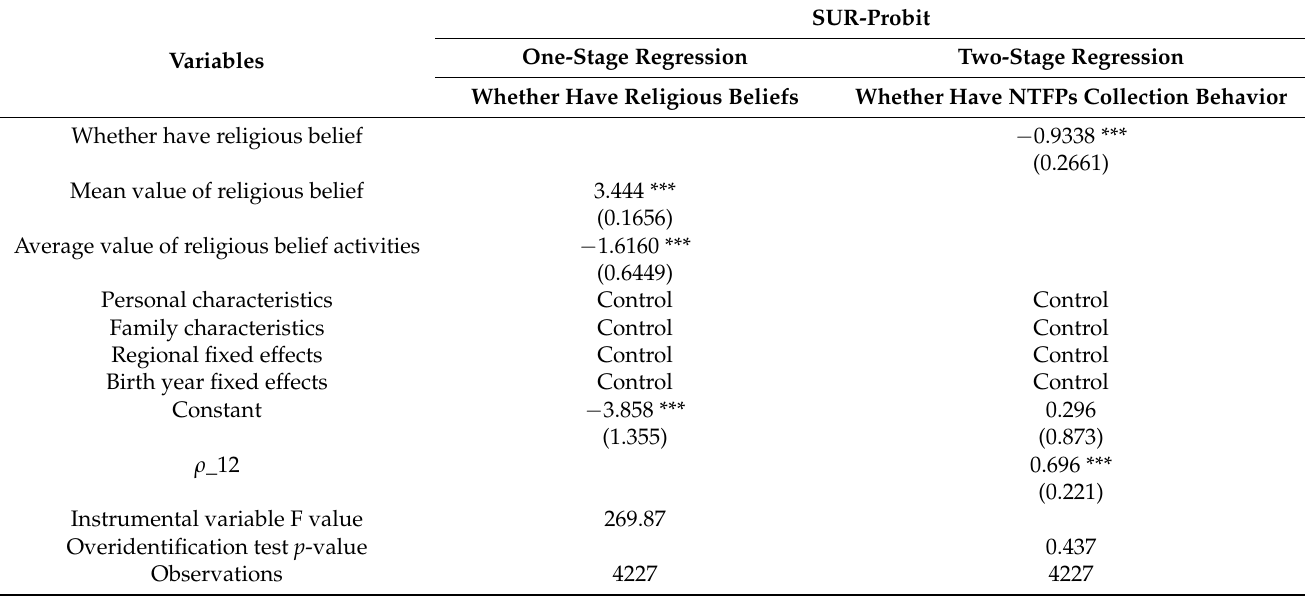
Table 6. The baseline regression for religious belief and NTFPs collection